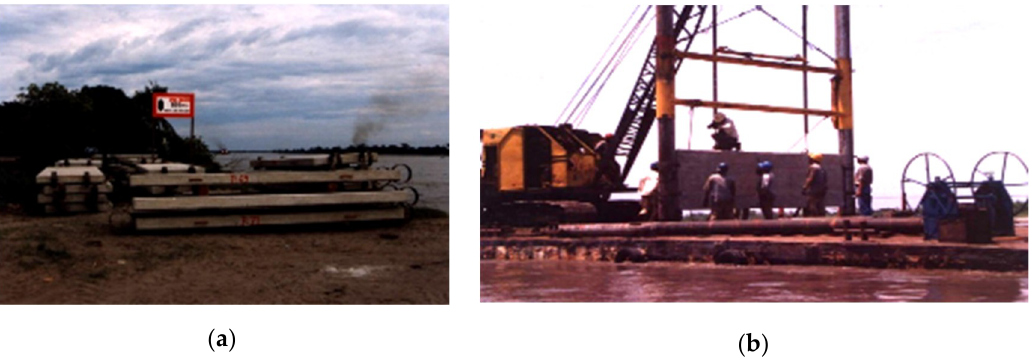
Figure 4. Magdalena River, ECOPETROL Aromatics pier: ( a ) storage of vanes in the riverfront before installation; ( b ) vane installation process (Hidroconsulta, 1993).